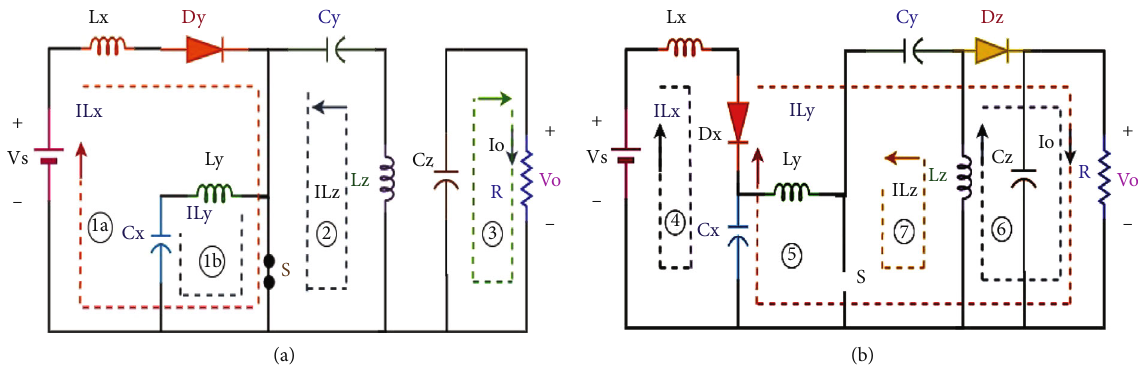
Figure 5: MSC operated at (a) mode1 (b) mode